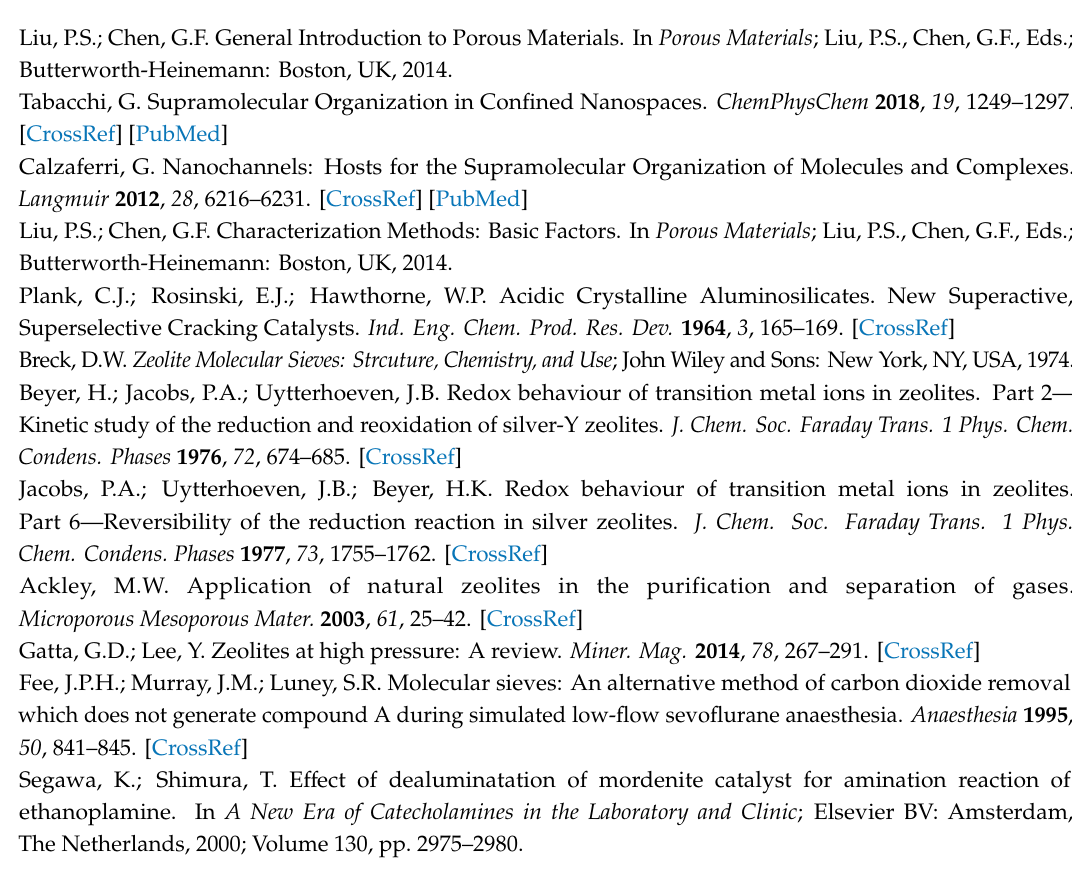
Figure S1: Polyhedral representations of ( a ) Li-MER, ( b ) Na-MER, ( c ) Ag-MER, ( d ) K-MER and ( e ) Rb-MER along (001) direction. Grey stick represents disordered Al / Si framework. Each colored beach ball represents extra-framework cation. Equatorial, hatched, and striped red balls represent oxygens of WO(1)–WO(3), WO(4), and WO(5), respectively, Figure S2: Comparison of channel opening area of d8r (black symbol) and pau (red symbol) along (001) direction and sum of two areas., Figure S3: Thermogravimetric analysis results of Li-, Na-, Ag-, and K-MER., Table S1: Cation-exchange conditions of MERs and chemical composition from Rietveld refinement and stoichiometric analysis., Table S2. Chemical composition calculated from Energy Dispersive Spectroscopy (EDS) method., Table S3: Refined cell parameters and atomic coordinates of M-MER at ambient condition (M = Li + , Na + , Ag + , K + and Rb + )., Table S4: Selected interatomic distances (Å) and angles ( ◦ ) for M-MER at ambient condition (M = Li + , Na + , Ag + , K + , and Rb +